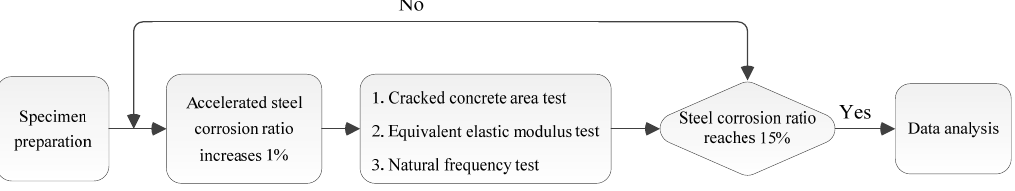
Figure 2. Experimental procedure.